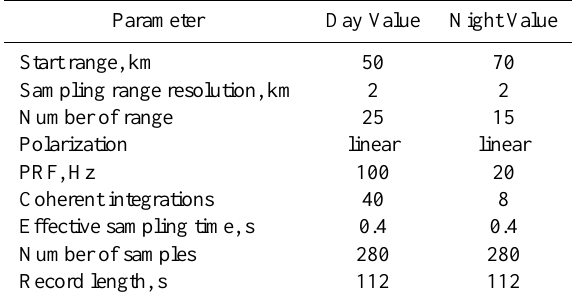
Table 2. Experimental parameters used for routine Spaced Antenna (SA) analysis for the Buckland Park MF